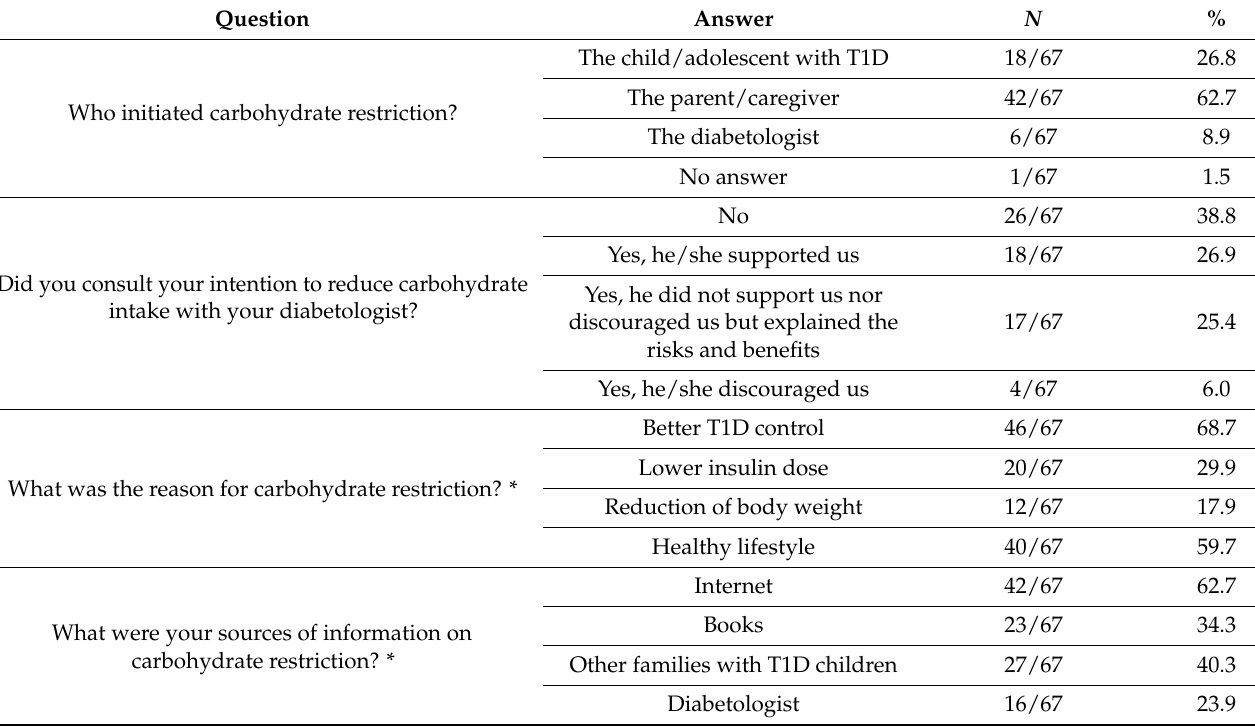
Table 2. Survey responses of the subjects with present or past experience with LCD ( N =